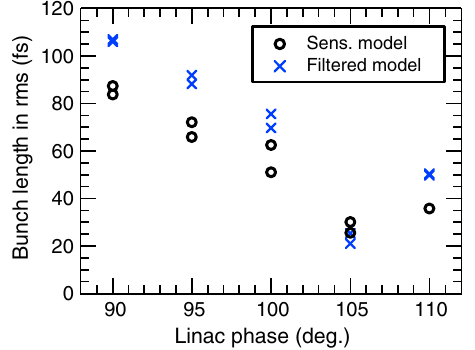
FIG. 5. Root-mean-square bunch length as a function of the accelerating phase in the linac measured with the bolometer. The interferograms were analyzed using the filtered model (cross) and the sensitivity model (circle).